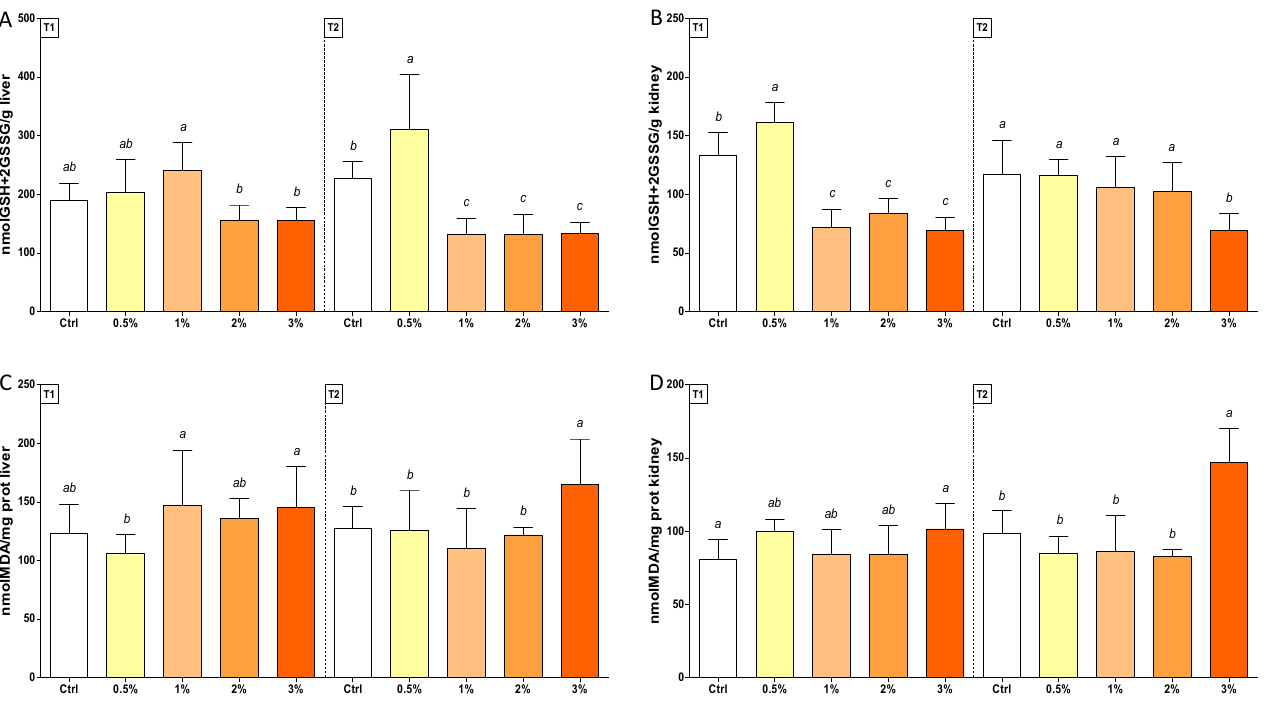
Figure 5. GSH + 2GSSG (Panel ( A , B )) and MDA (Panel ( C , D )) levels in livers (on the left, Panel ( A , C )) and kidneys (on the right, Panel ( B , D )) of rainbow trout Oncorhynchus mykiss fed with F1-BEO-supplemented diets (0.5%, 1%, 2%, 3% ( w / w ) supplementation) after 15 (T1) and 30 (T2) days. Different lowercase letters indicate statistically significant differences among experimental groups ( p < 0.05) for each experimental